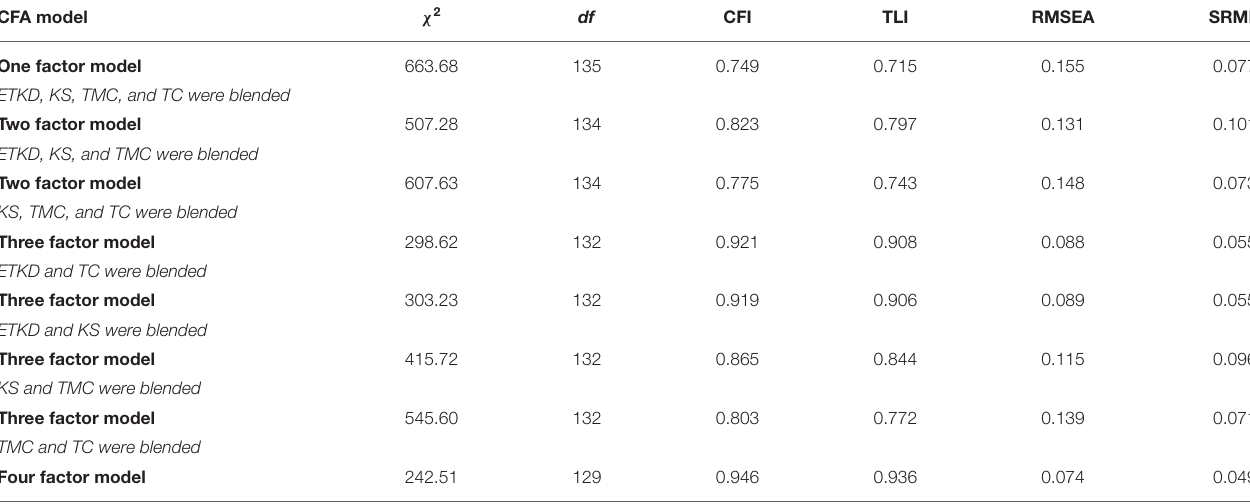
TABLE 3 | Results of confirmatory factor